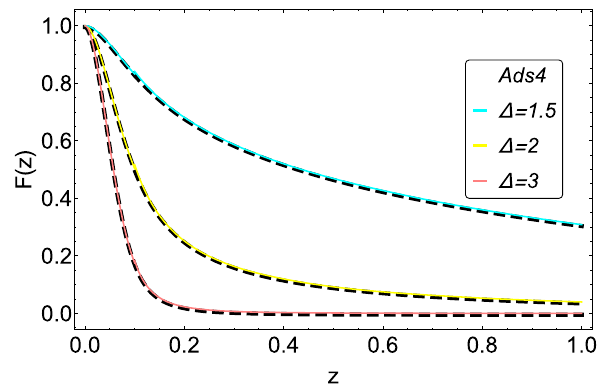
Fig. 19 The field F for (cid:2) = 1 . 5 (light blue), (cid:2) = 2 (yellow), (cid:2) = 3 (pink) at b = 10. Solid colored curves are analytic expres- sion Eqs. (A.60) and (A.61) and dashed curves are exact numerical results Eq. (A.22a) with Eq. (A.37) (almost